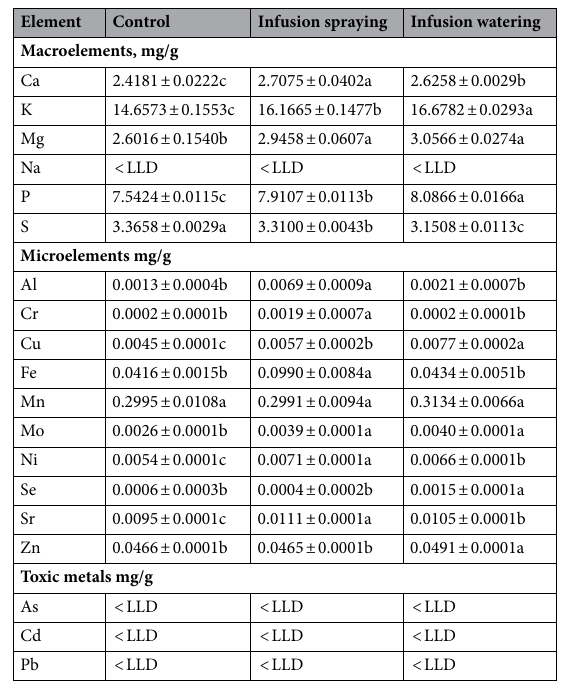
Table 5. Effect of soybean treatment with extracts from Levisticum officinale on the content of elements in its seeds (means of 2018–2020 ± SD). < LLD—below limit of detection; Means in the rows, concerning the selected traits, followed by different letters are significantly different at p <